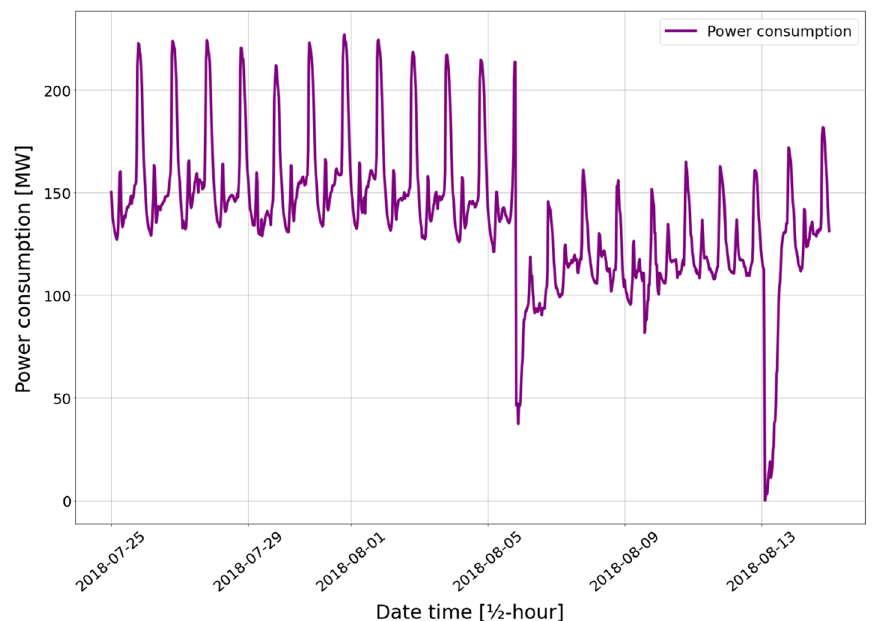
Fig. 29 Load profile of the 10 days before and 10 days after the earthquake in Lombok on 5 August